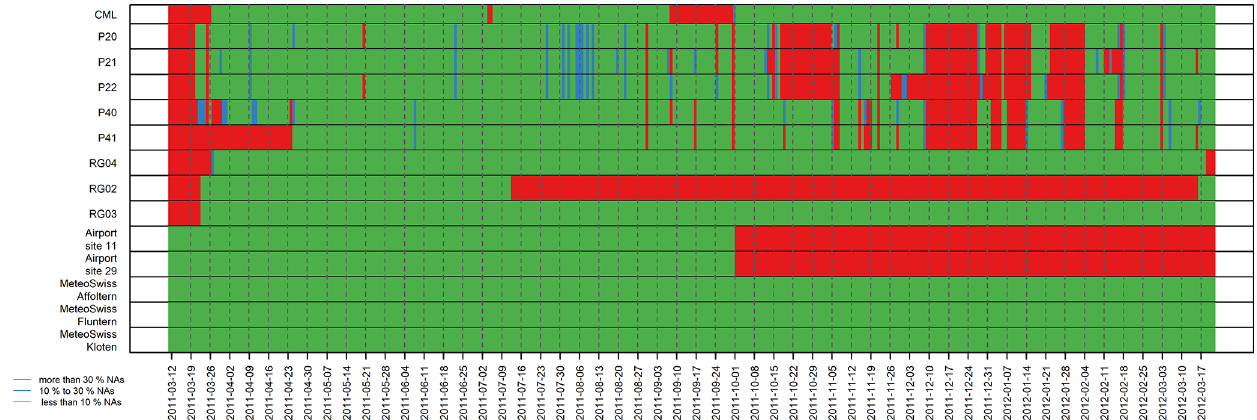
Figure J1. Data availability scheme. Red means more than 30% NA values. Blue means 10% to 30% NA values. Green means less than 10% NA